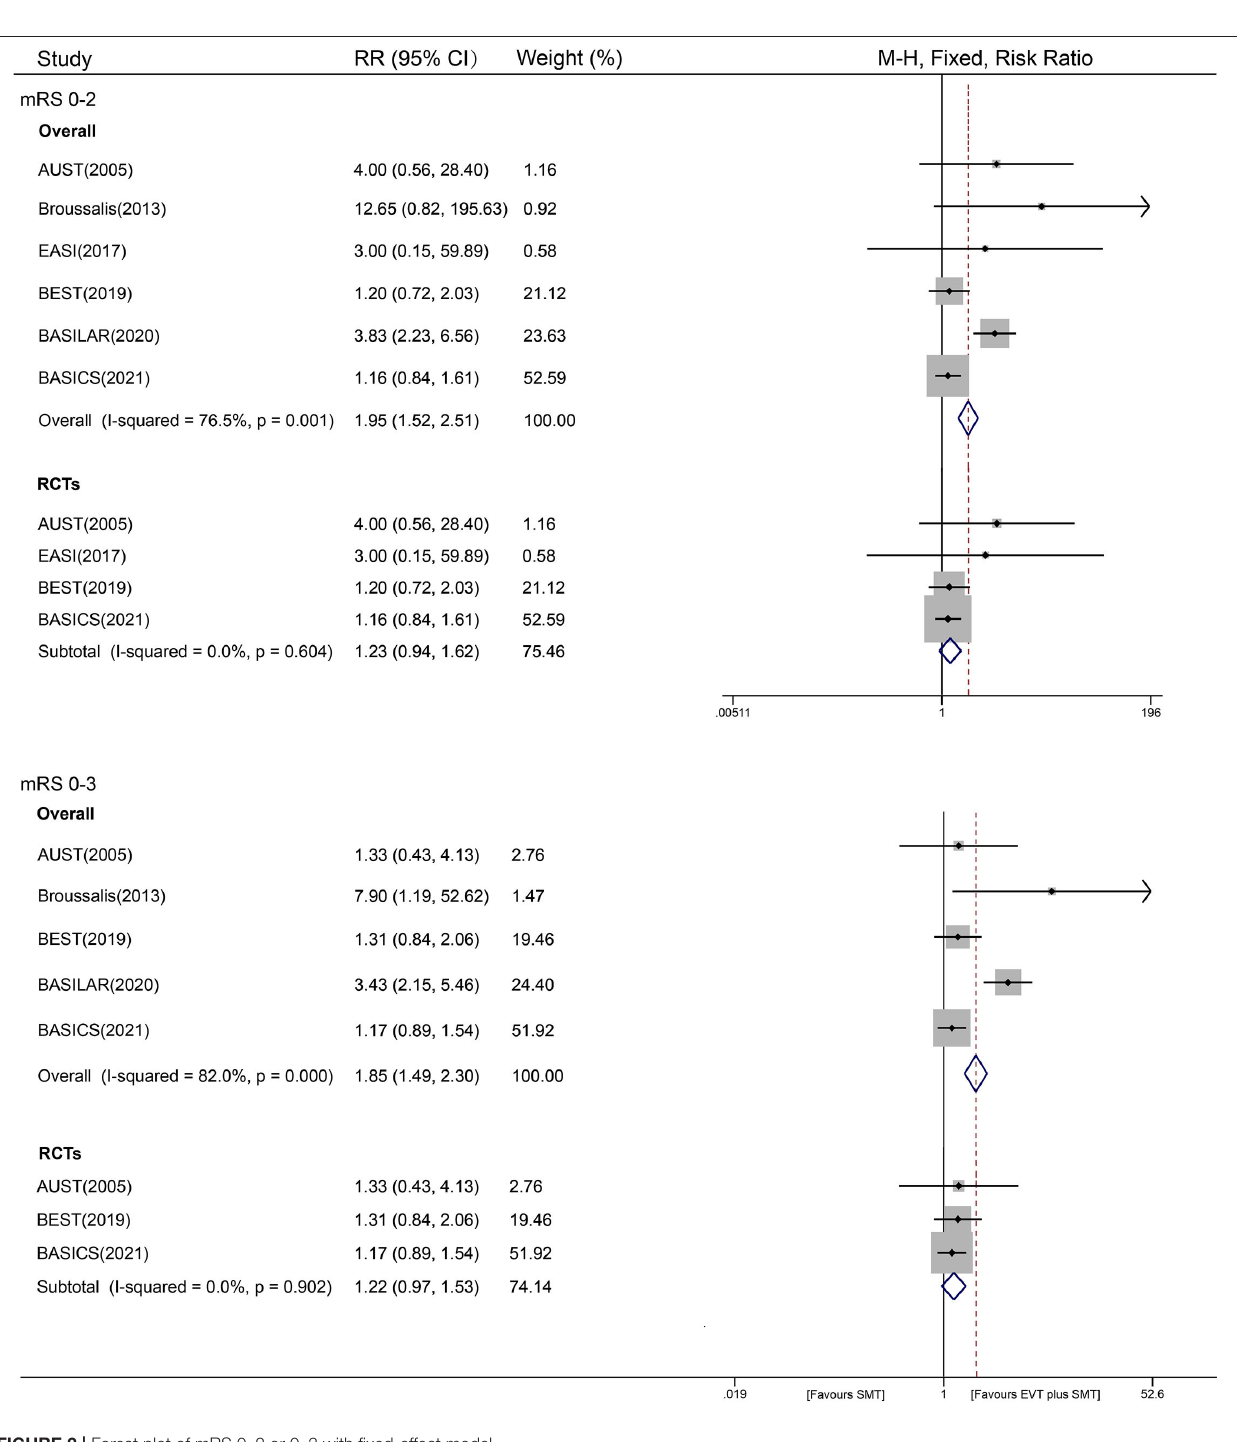
detected in both non-RCTs ( I 2 = 96.1%, P < 0.001) and RCTs ( I 2 = 94.2%, P < 0.001) ( Figure 3 ). In this outcome, all